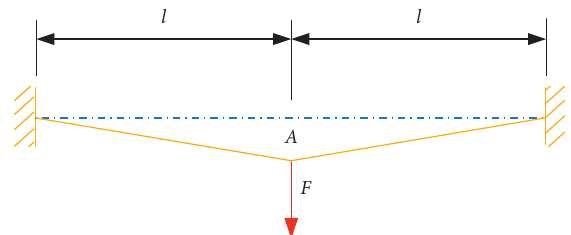
Figure 3: Force analysis of single string in badminton